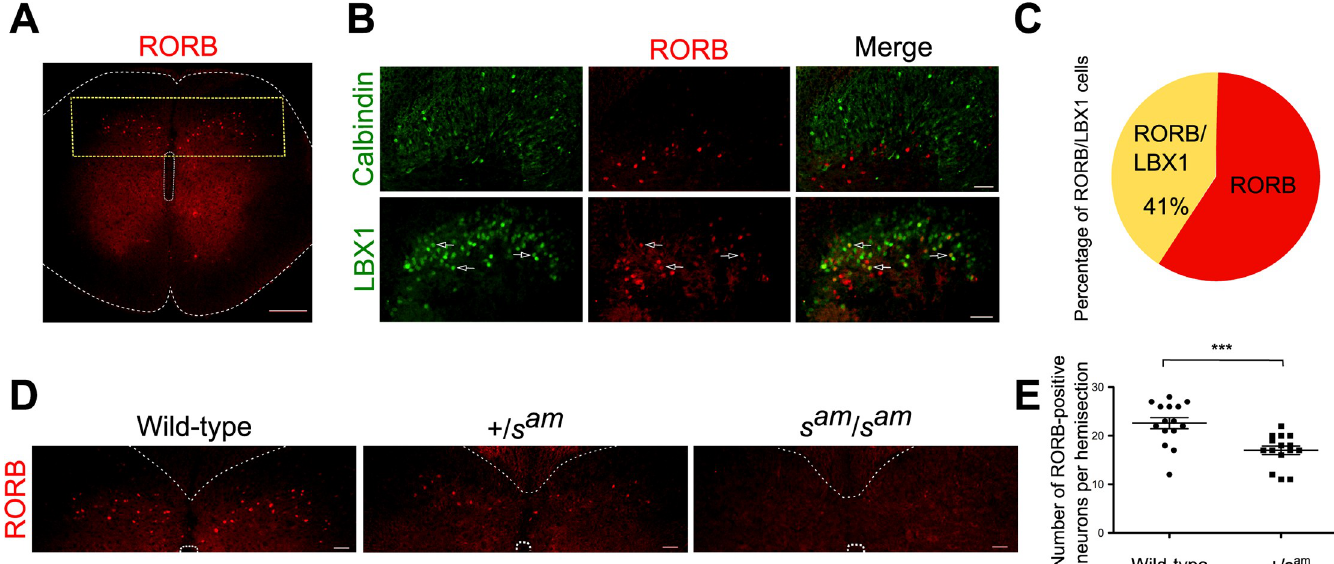
Fig 4. The number of RORB-positive neurons are drastically reduced in the spinal cord of sauteur rabbits. Immunohistochemistry (IHC) on newborns rabbit spinal cord. (A) In wild-type rabbits, RORB-immunopositive neurons are localized in the spinal cord dorsal horn (n = 5 animals, yellow dot rectangle = magnified areas in D). (B and C) Most of the RORB-immunopositive neurons are localized below Calbindin-expressing neurons and around 40% of them co-expressed LBX1 (arrows) (n = 547 cells from five wild-type animals). (D and E) In sauteur animals ( s am / s am ), the number of RORB immunopositive neurons was strongly decreased (no IHC staining, n = 6 animals) and in the heterozygous animals ( +/s am ) the number of neurons is decreased by approximately 25% (n = 379 cells from 3 animals). (Two-tailed Mann Whitney test, P = 0.0007) (Scale bars: 200 μ m for A and 50 μ m for B and